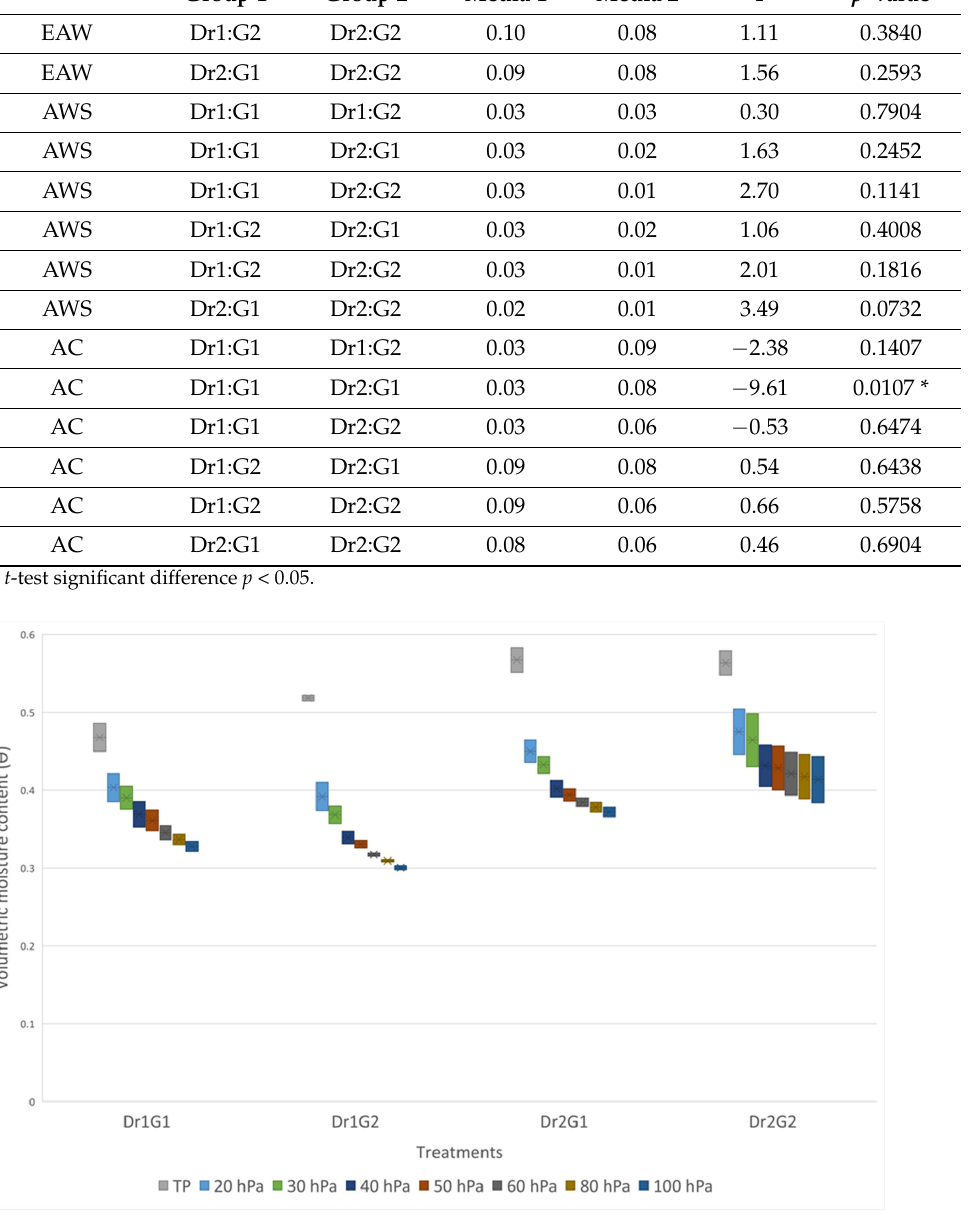
Figure A1. Whisker plot of water availability test of the samples of depth cushioning after the treatments of drainage package (D1: without drainage package and D2: with drainage package) and geotextile addition (G1: 0 addition and G2: 2 kg/m 2 ). T-test signi fi cant di ff erence p < 0.05.